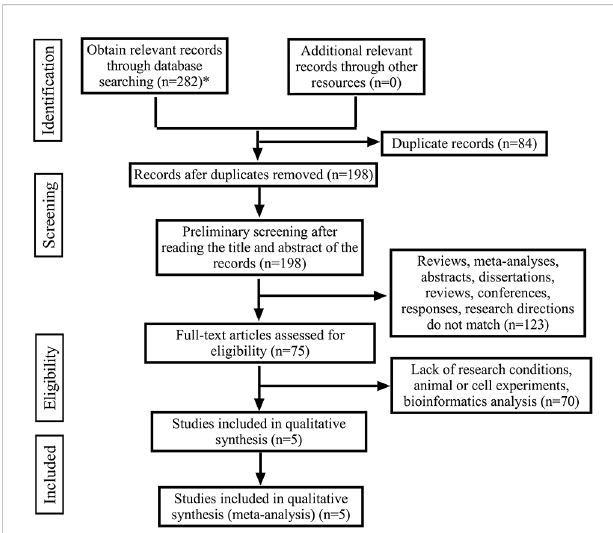
FIGURE 1 The fl ow diagram of the publication search, selection and exclusion process. (*The databases searched and the number of documents detected are as follows: Pubmed (n=21), Cochrane library (n=0), Scopus (n=131), Ovid (n=9), Embase (n=17), Ebsco (n=40), Web of Science